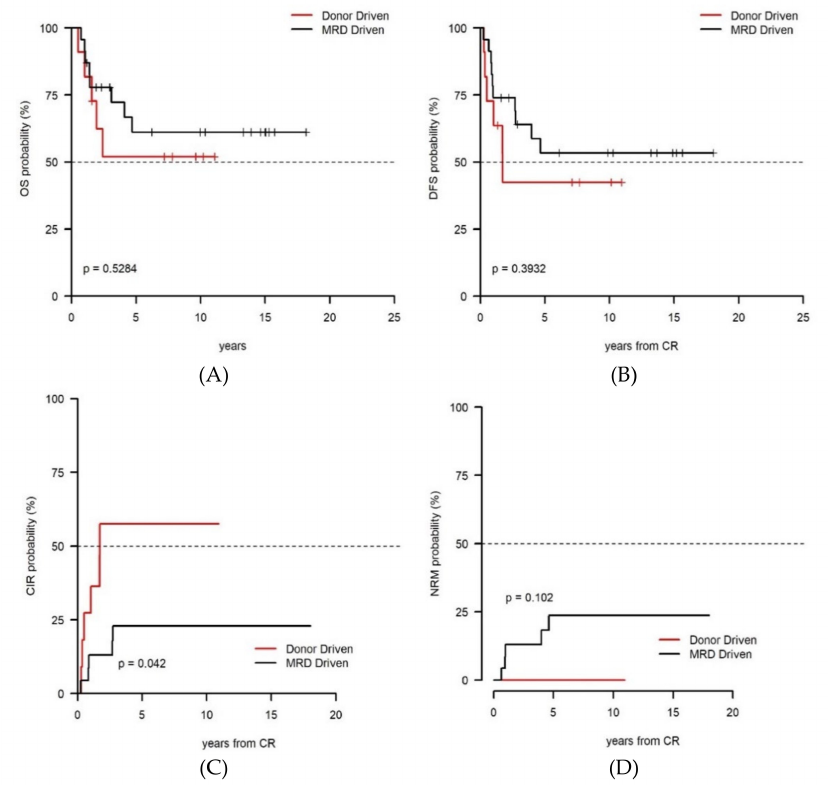
Figure 3. In favorable-risk karyotype MRD-oriented cohort had a better, even if not significant, outcome as compared the donor-oriented cohort. OS ( A ) and DFS ( B ) in the MRD-driven cohort were 61.1% and 53.4% versus 51.9% and 42.4%, respectively, of those in the Donor-driven cohort ( p = 0.528 and p = 0.393, respectively). The superior outcome of the MRD-oriented cohort was mainly due ( C ) to a significantly lower CIR (22.8% vs 57.6%, p = 0.042) that however was counterbalanced ( D ) by a higher NRM in the MRD driven cohort due to the higher alloHCT